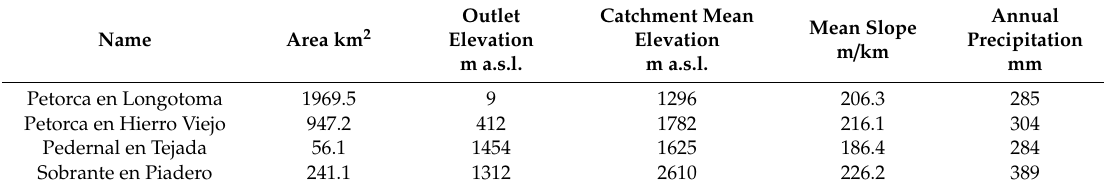
Table 2. Characteristics of the four studied catchments in the Petorca Basin used for hydrological analyses.